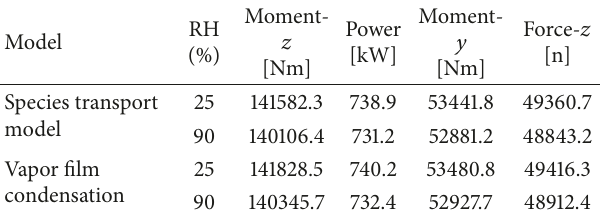
Table 5: Blade aerodynamic performance at velocity = 8m/s with species transport model and vapor film condensation model at temperature of 303 K